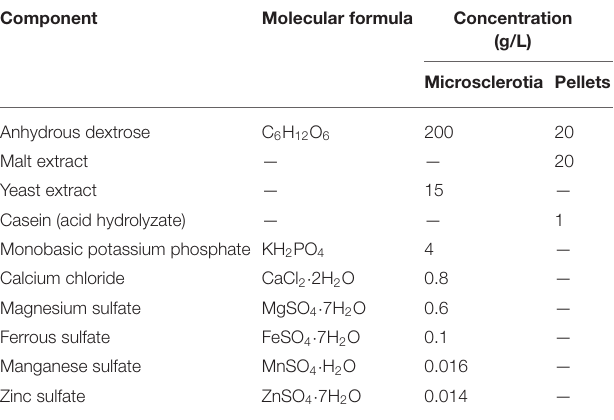
TABLE 1 | Components of basal media used to obtain microsclerotia and pellets.